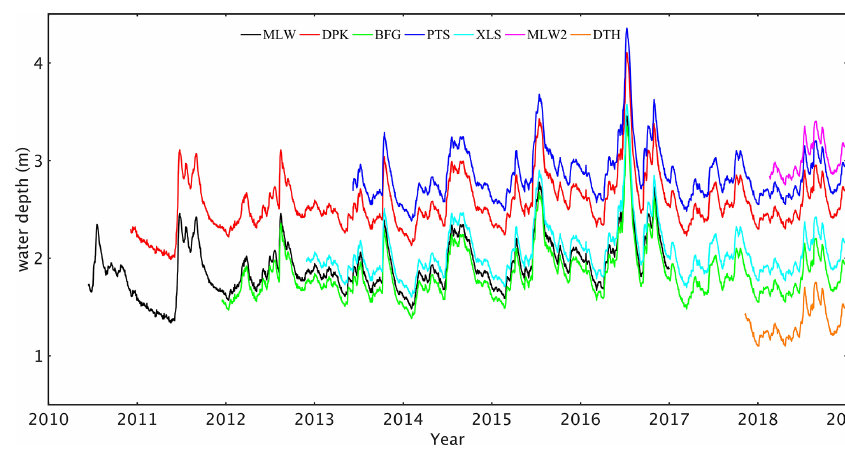
Figure 2. Water depth at the eddy covariance sites. Table 2. Percent of data coverage. The percentage represents the proportion of high-quality original measurement.